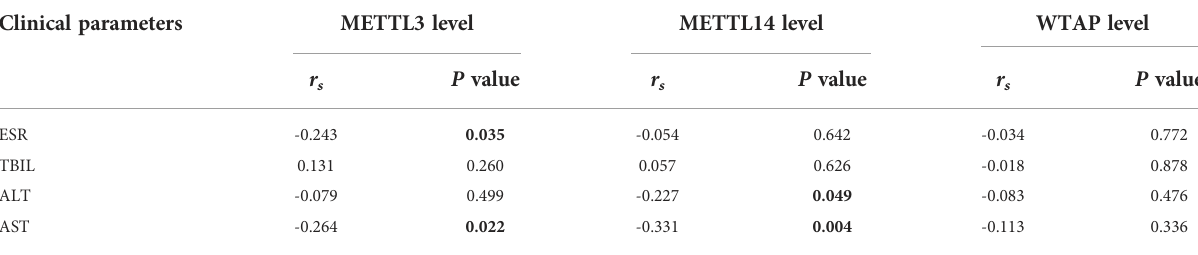
TABLE 5 The correlation between METTL3, METTL14, and WTAP transcription levels and ESR, TBIL, ALT, AST of PTB patients. Clinical parameters